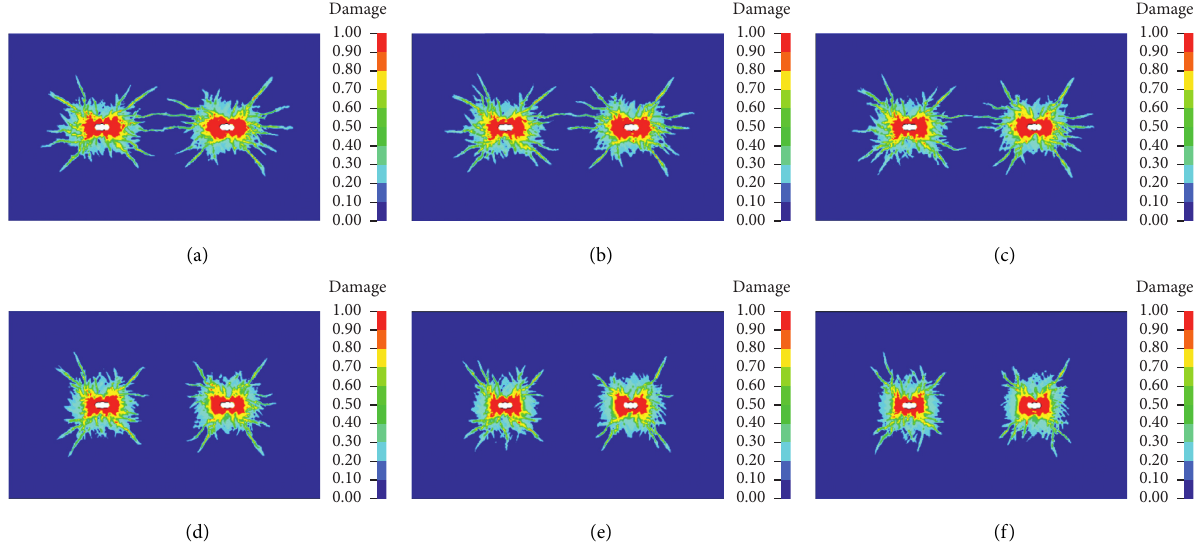
Figure 7: The effect of double-hole blasting of cutting seam charge under different vertical ground stresses. (a) σ (c) σ y � 30 MPa. (d) σ y � 50. MPa. (e) σ y � 60MPa. (f) σ y �